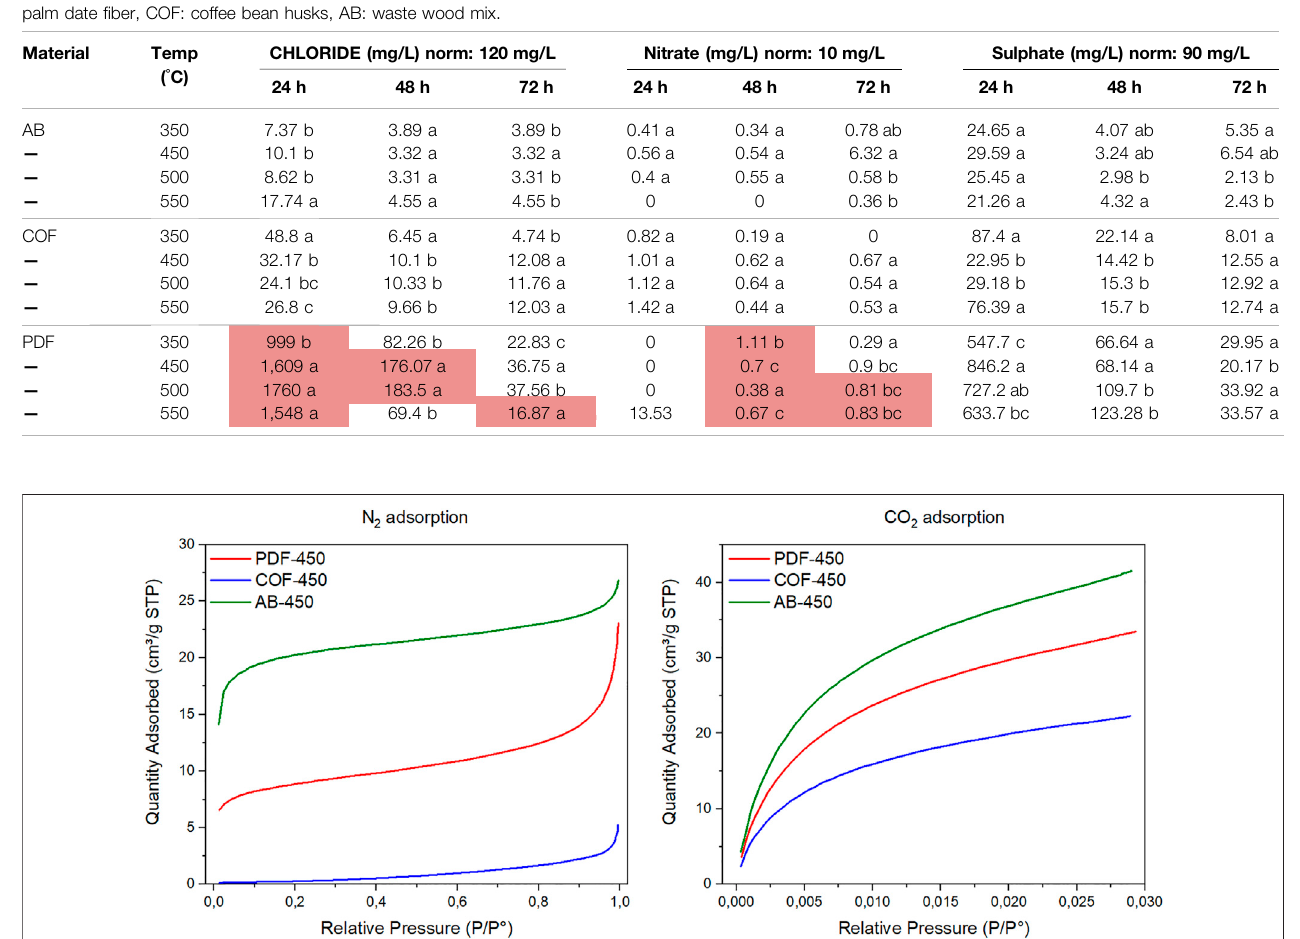
FIGURE 2 | Nitrogen and carbon dioxide adsorption isotherm of the biochars. The N 2 and CO 2 adsorption isotherms were taken at 77.35 and 273.15 K respectively.